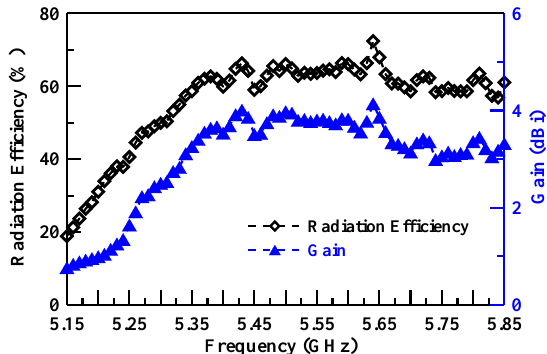
Figure 13. Upper band gain and radiation efficiency measurement results.